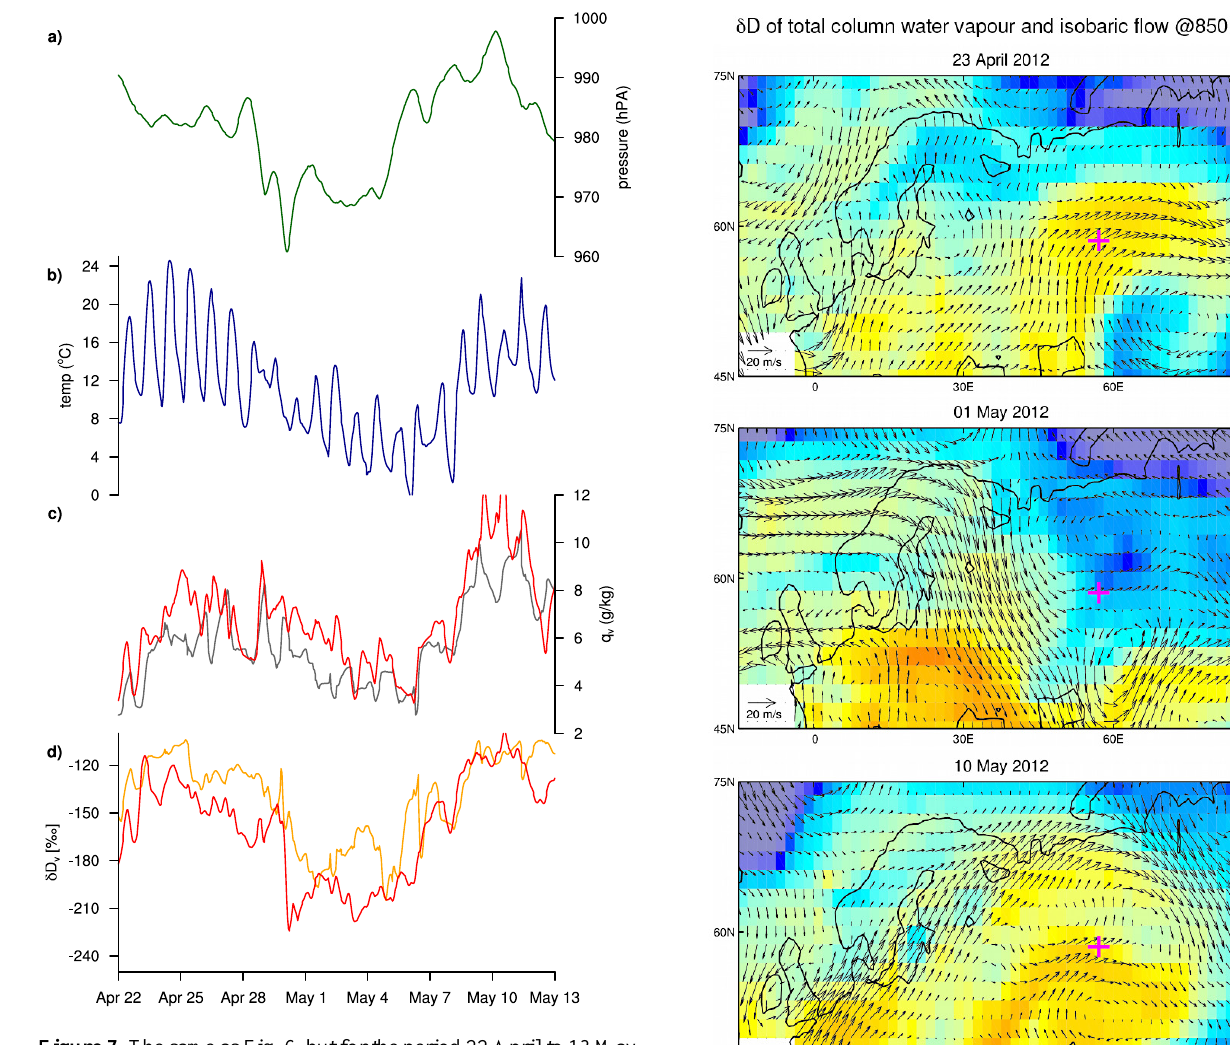
Figure 7. The same as Fig. 6, but for the period 22 April to 13 May.